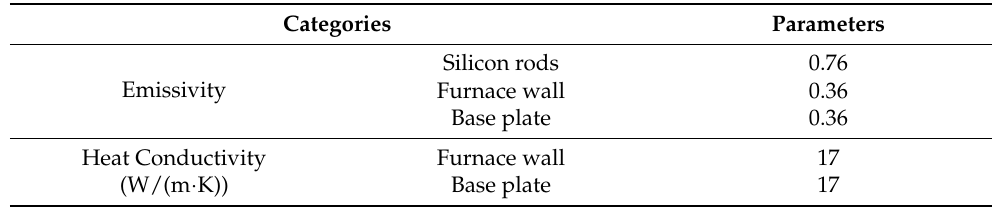
Table 3. Boundary